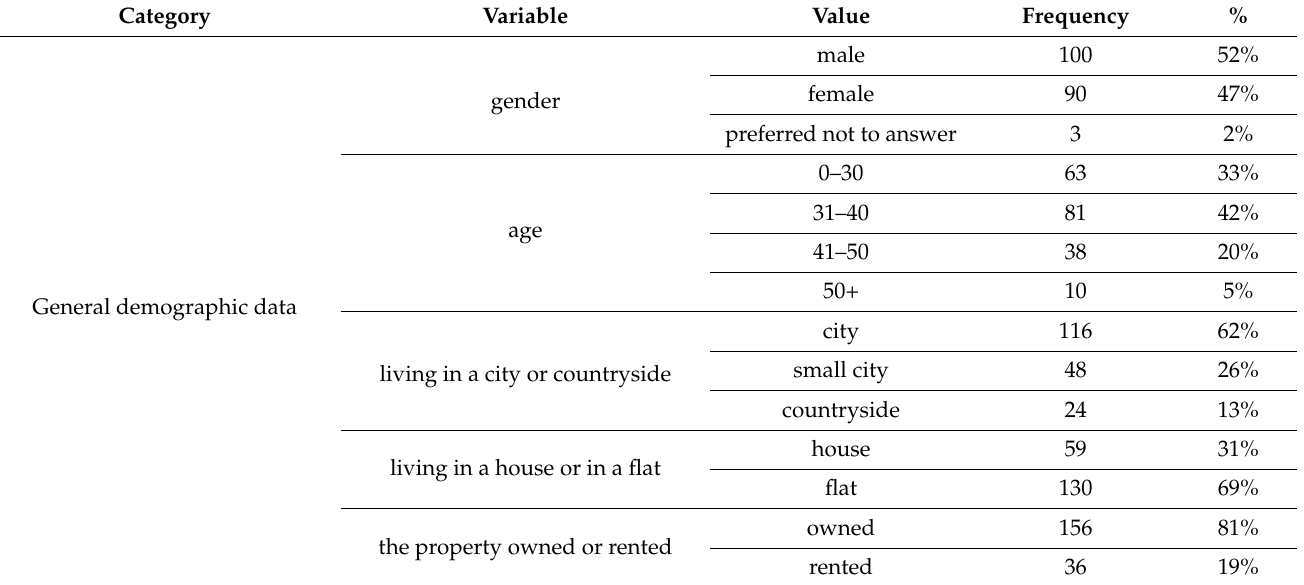
Table 2. Consumers’ general demographic